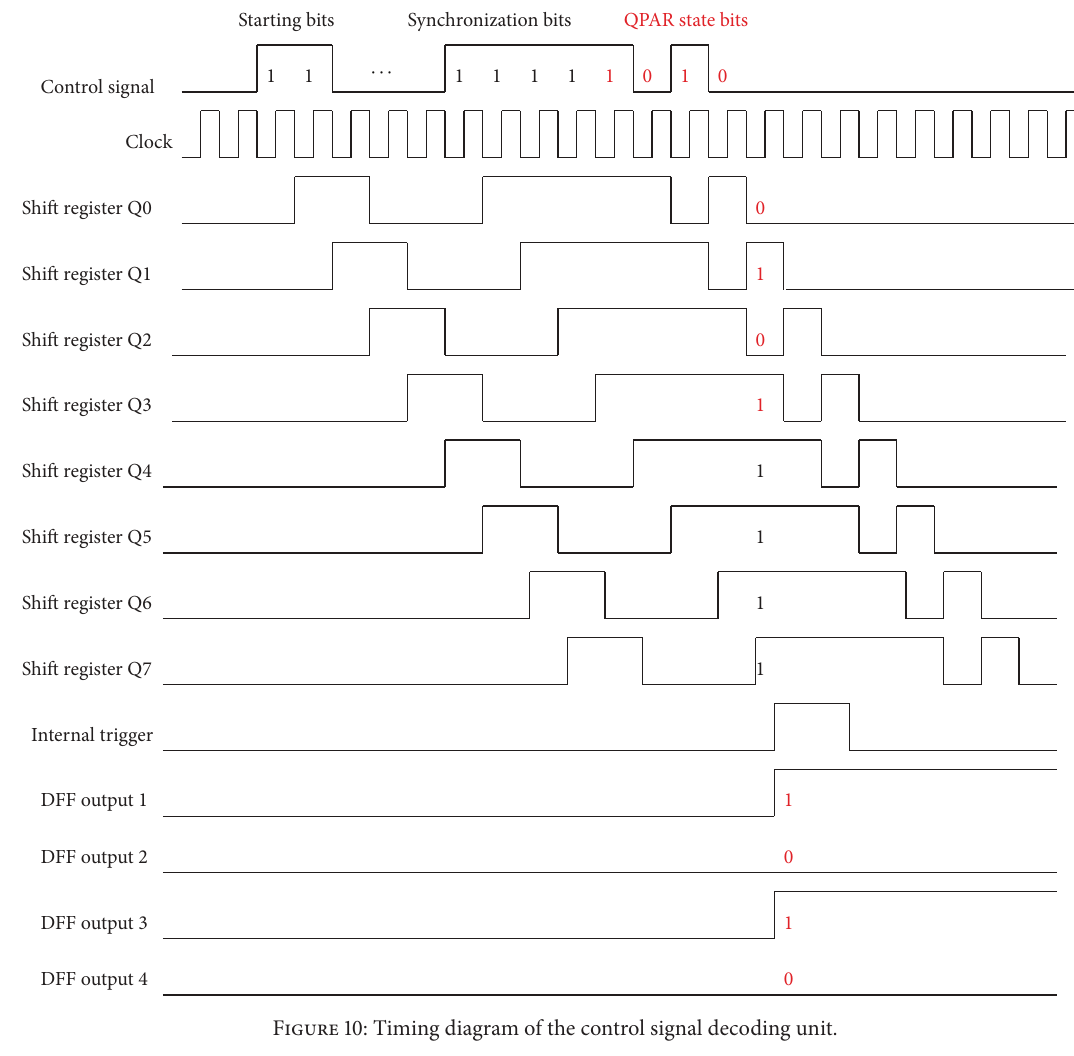
Figure 13. The power laser was operated at the 1480 nm wavelength, while the control light and payload signal was transmitted at 1553 nm and 1595 nm, respectively. The 1564– 1620 nm/1504–1557 nm/1484–1497 nm band coupler/splitter was used to couple/decouple the power, control, and signal